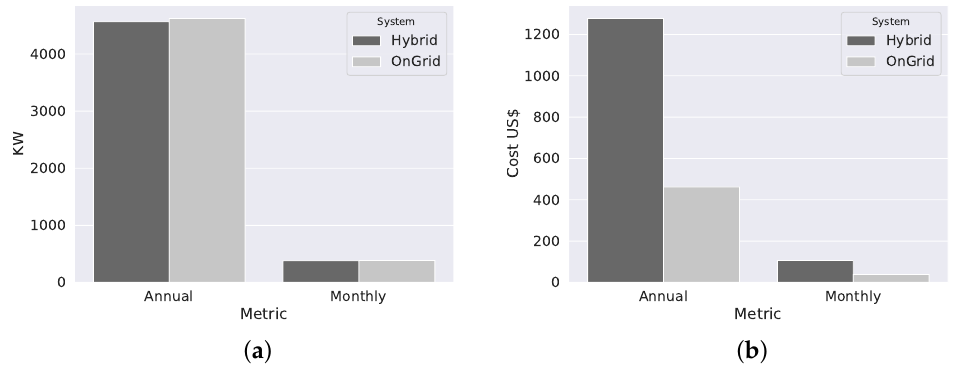
Figure 10. ( a ) KW consumed. ( b ) Value spent.